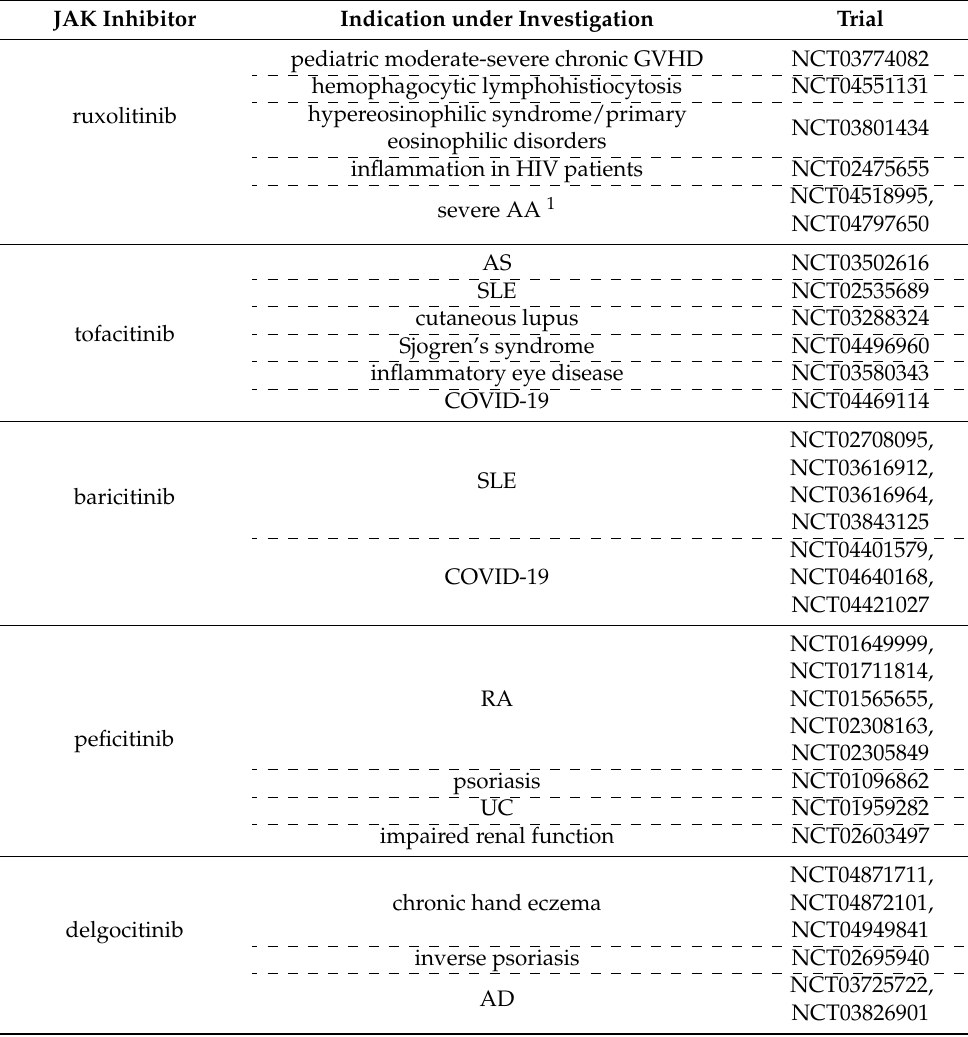
Table 2. Summary of jakinib